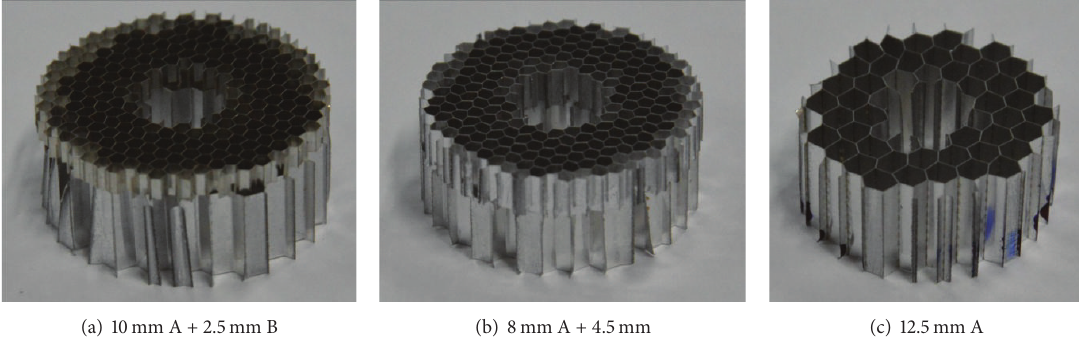
Figure 2: Aluminium honeycombs